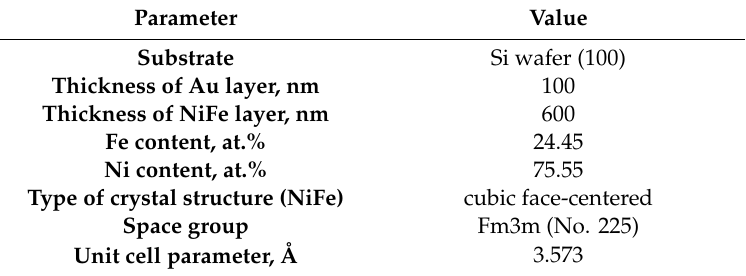
Table 2. Features of the as-prepared Au / NiFe nanostructured